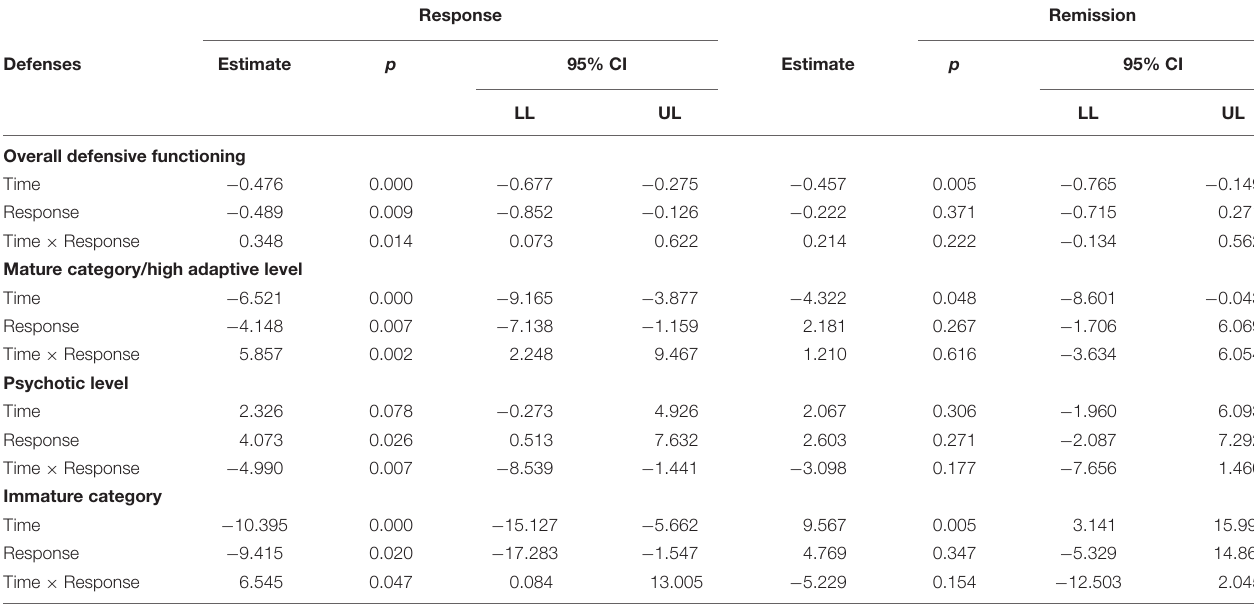
TABLE 3 | Relation among defenses and treatment response and remission.